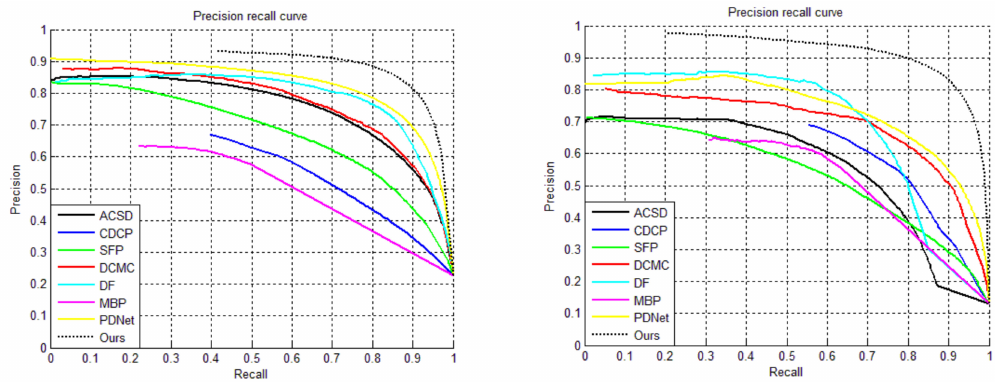
Figure 2. Precision–recall curves of di ff erent methods on the testing set of the NJUD and NLPR datasets.